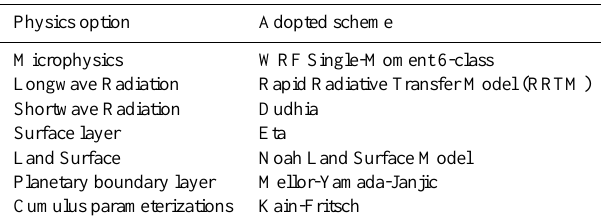
Table 4. Physics schemes (Skamarock et al., 2008) adopted for the WRF